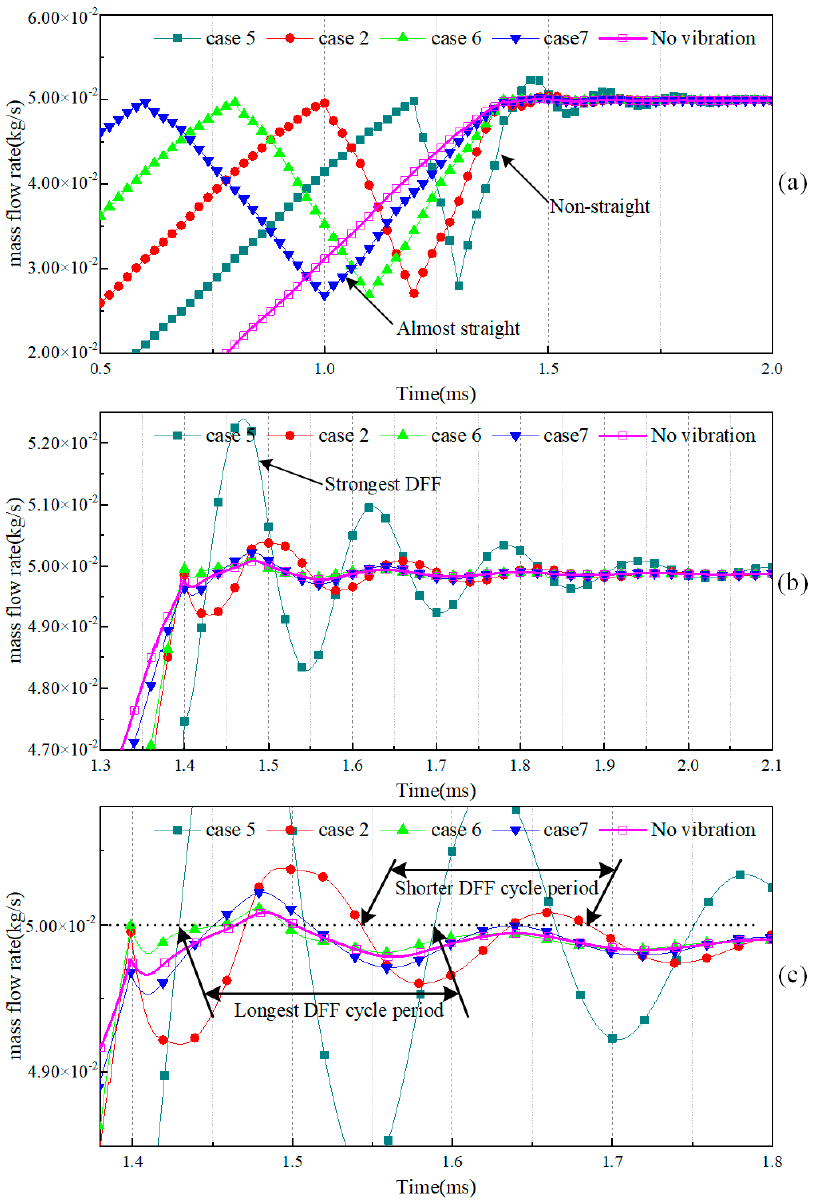
Figure 8. Effect of the valve lift-vibration period on the mass flow rate of the NG injector (( b , c ) are the partial enlargements of ( a )).